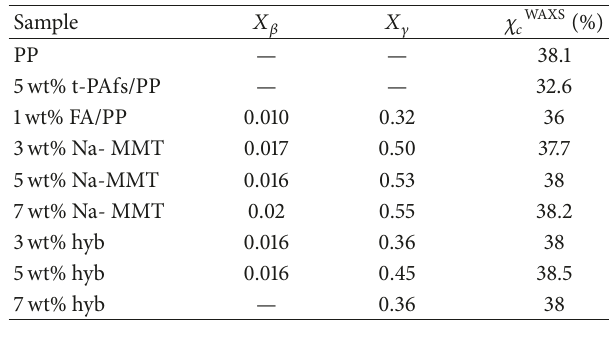
Table 2: WAXS measurements: ( 𝜒 𝑐 WAXS ), 𝑋 𝛽 of 𝛽 form and 𝑋 𝛾 of the 𝛾